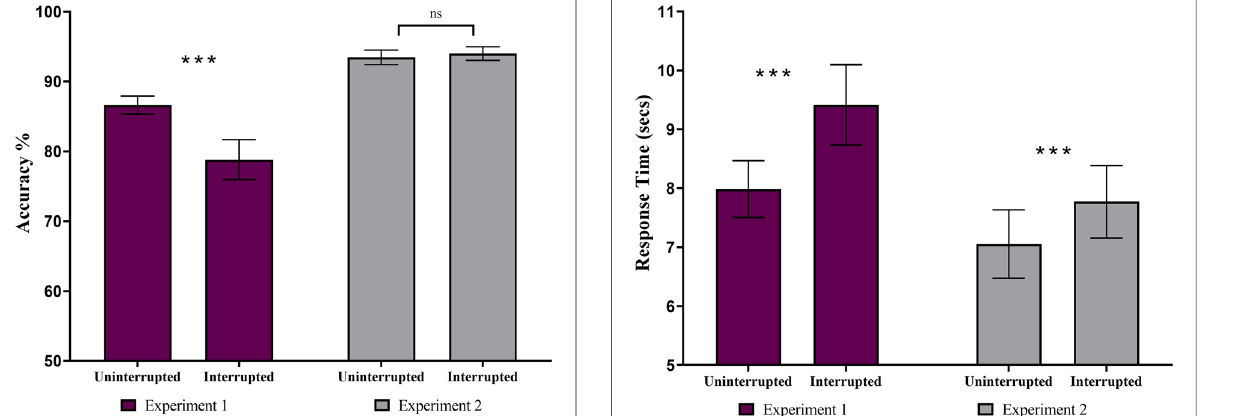
Fig. 4 There was a significant main effect of trial-type (uninterrupted, interrupted) on primary task RTs. The main effect of search-type (Exp. 1: search for different targets, or Exp. 2: search repeatedly for the same target) was not significant. The interaction between trial-type and search-type was significant. Critically, RTs were significantly slower during interrupted trials in Experiment 1 and Experiment 2. The stars denote significance (* p < .05, ** p < .01, *** p < .001).The error bars represent the standard error of the